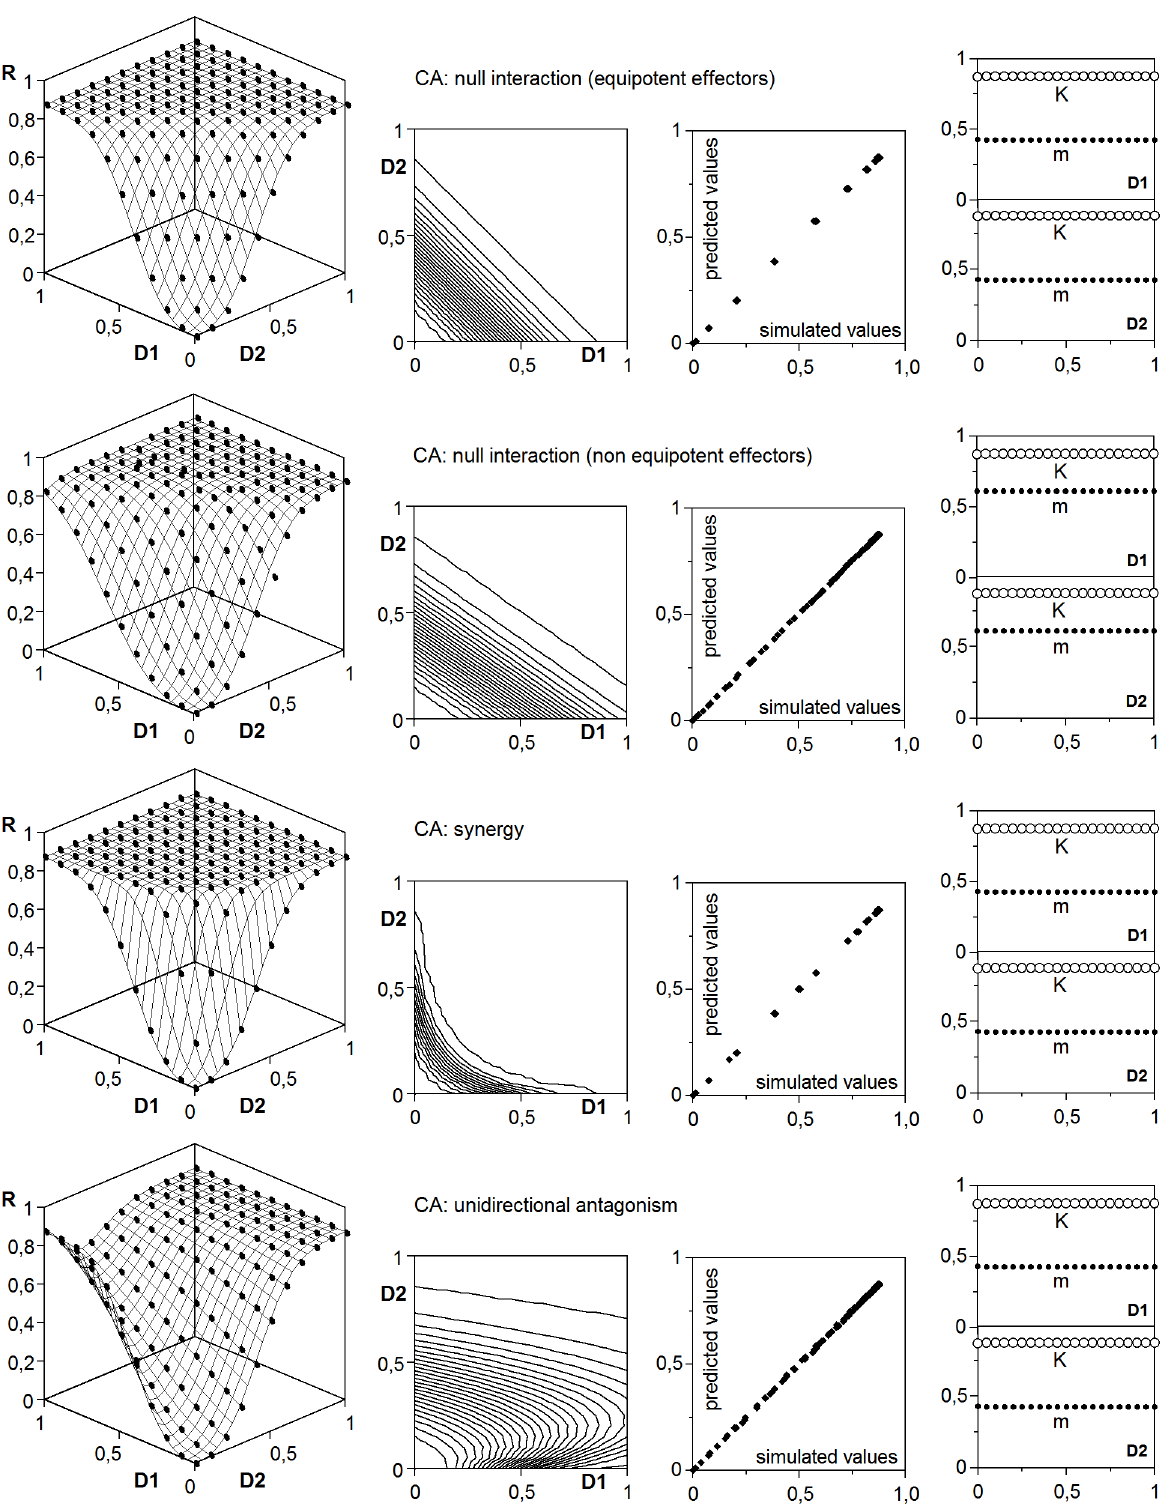
Figure 8. Joint response to two effectors under CA mode of action. Concrete types of interactions are specified and adjusted to the generalized model (32). Keys and graphic criteria as in Figure 6. See also Table 5.